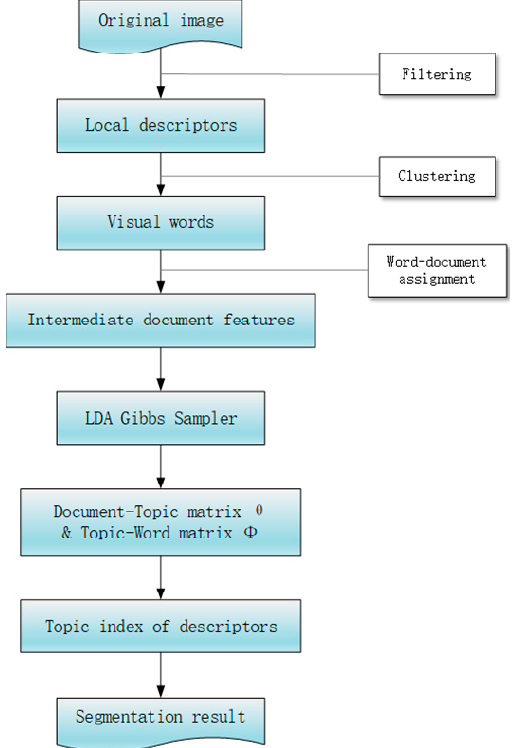
Figure 3. LDA segmentation algorithm flow.